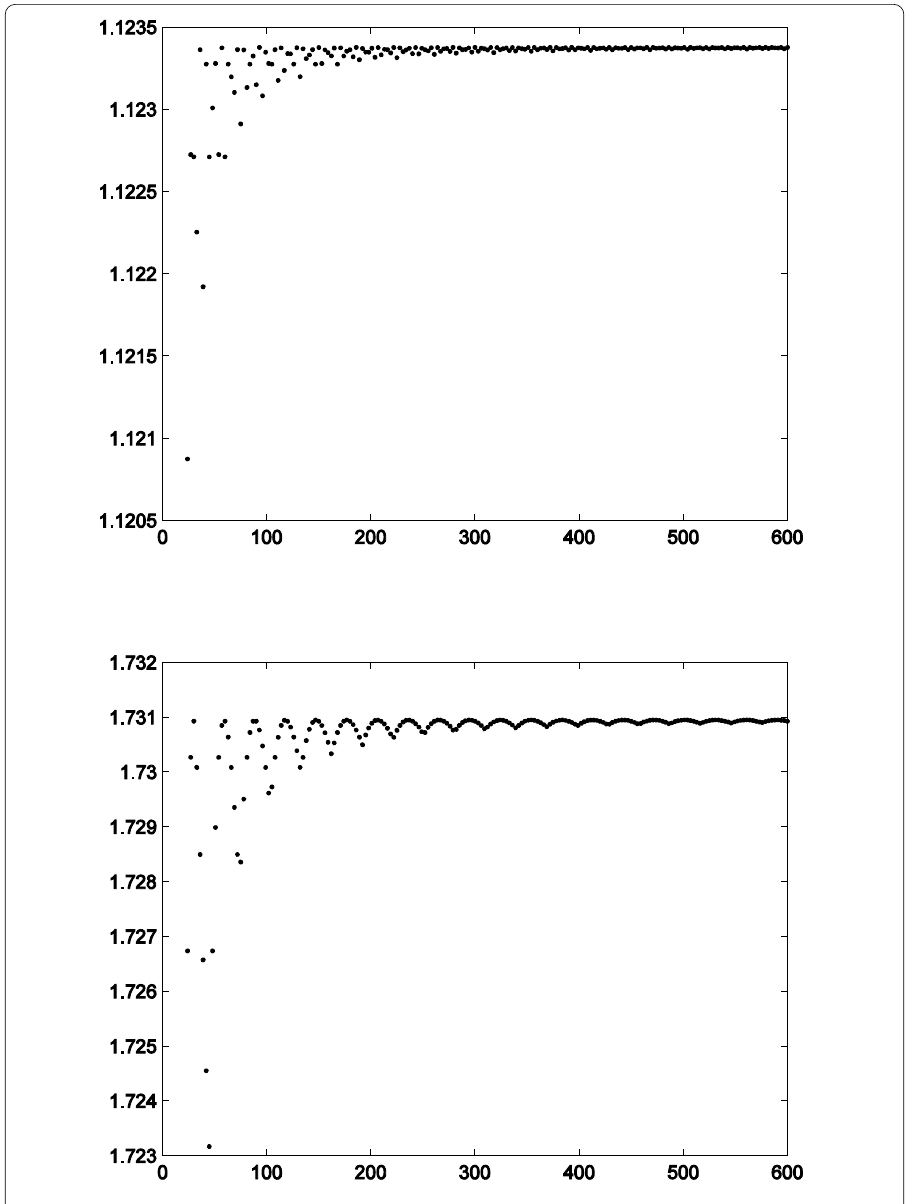
Figure 1 The spectral radius of MM T and (cid:6) M (cid:6) M T , respectively (from top to bottom)